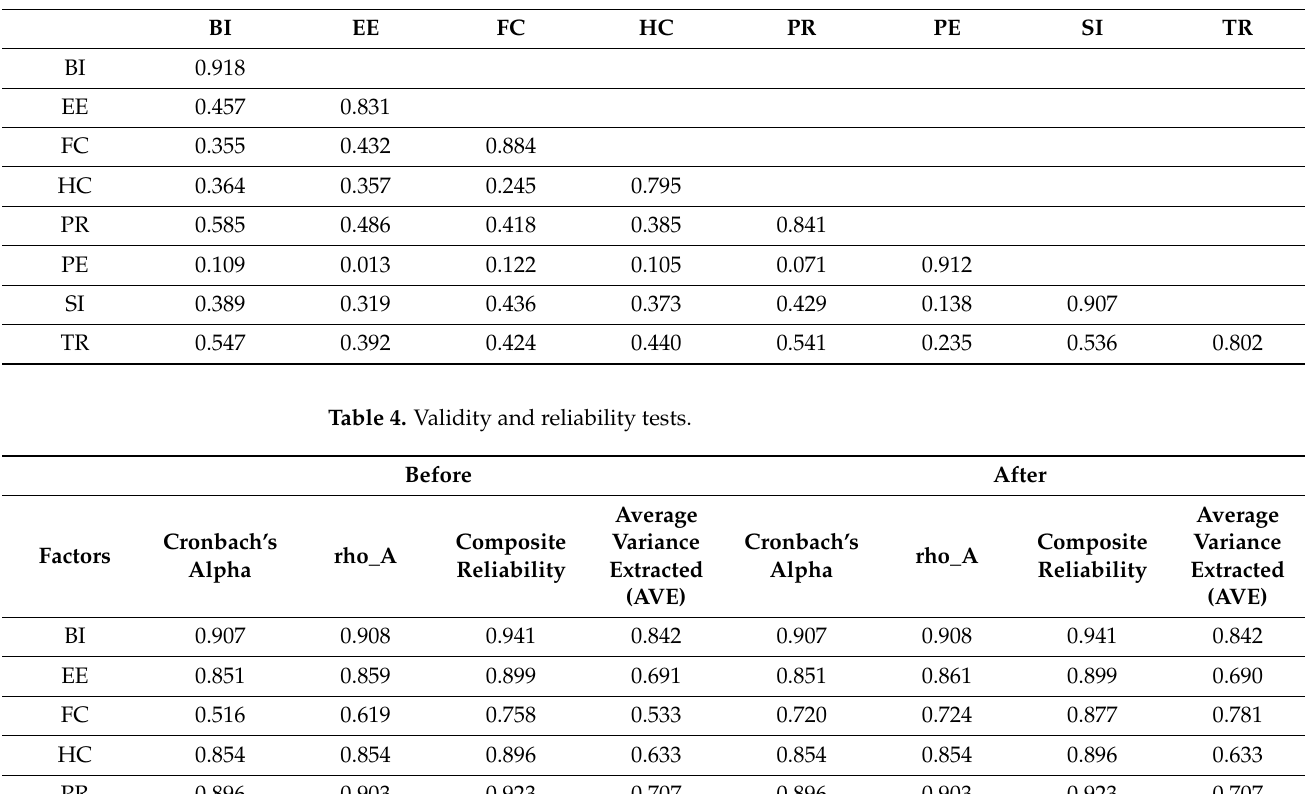
Table 4. Validity and reliability tests.